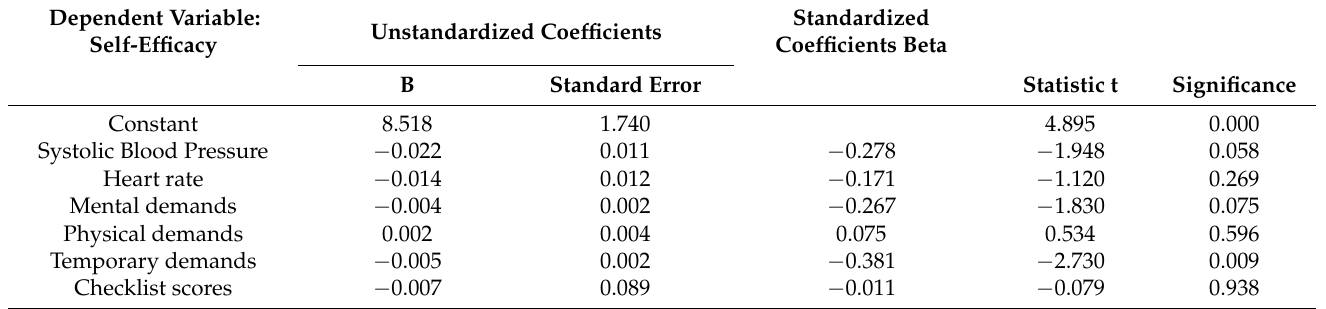
Table 5. Multiple linear regression analysis to model the relationship between differences in pupil diameters and physiological parameters (systolic blood pressure and heart rate pre-test), NASA-TLX workload demand (physical, mental and temporal demands), and checklist